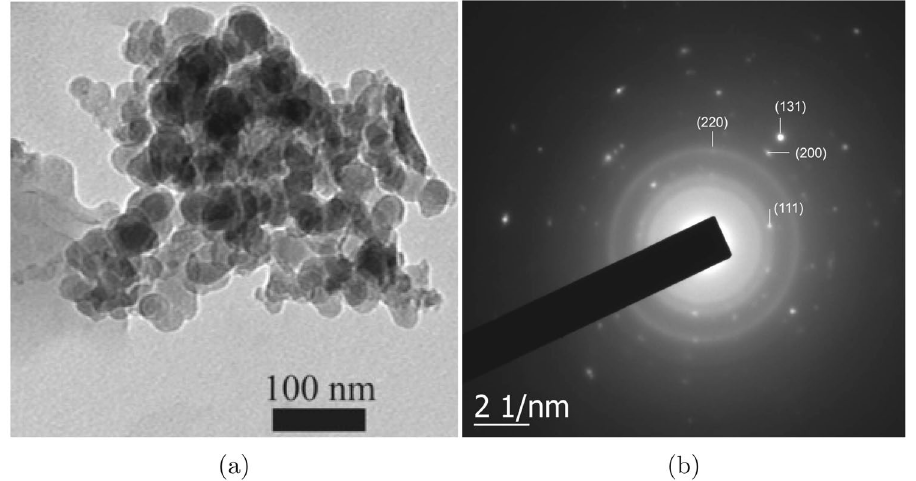
Figure 2. ( a ) HRTEM image of pure Ni NP’s, and ( b ) the corresponding SAED patterns. Initial four rings are indexed with a tag on a bright spot of a